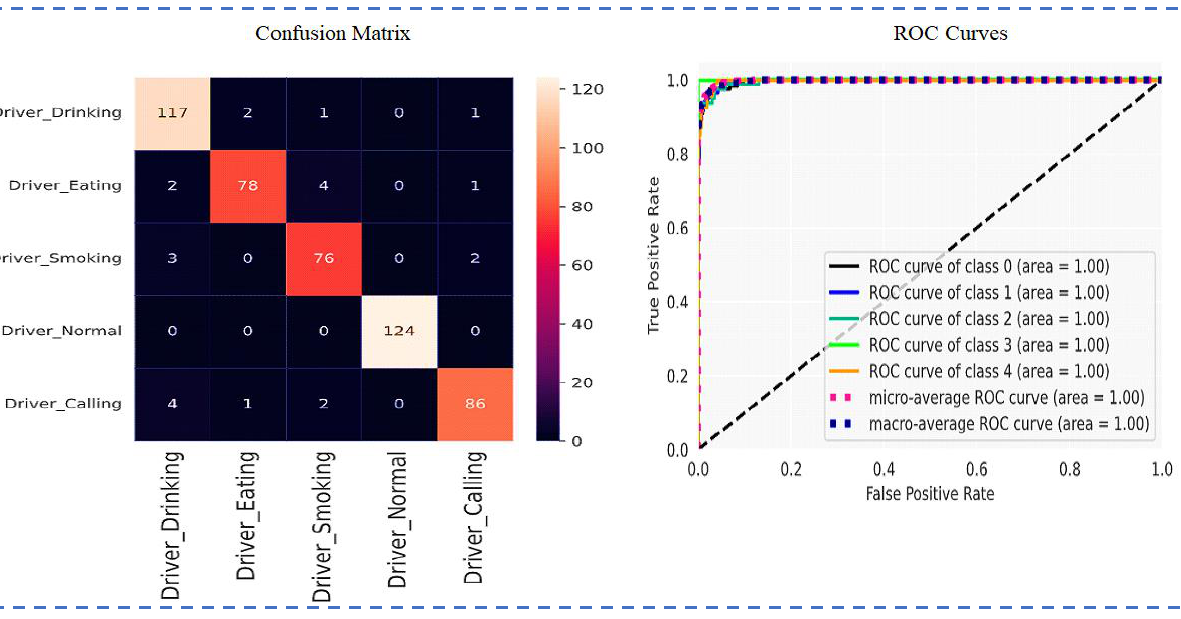
Figure 15. Confusion matrix and ROC Curves using the proposed CNN-based model. The comparison value of Accuracy, Precision, Recall, F1-measure and support value for the five classes using the proposed CNN-based model and pre-trained models ResNet101, VGG-16, VGG-19, Inception-v3 are given below in Table